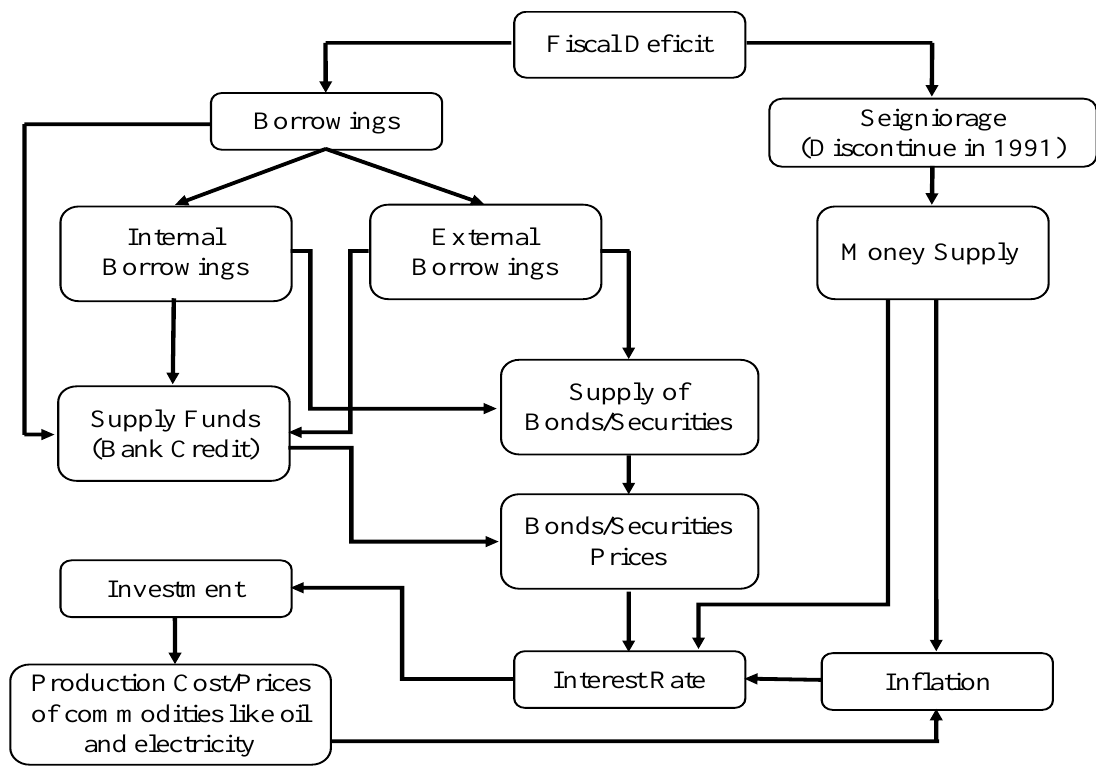
Figure 1. Transmission channel of fiscal deficit and Inflation.